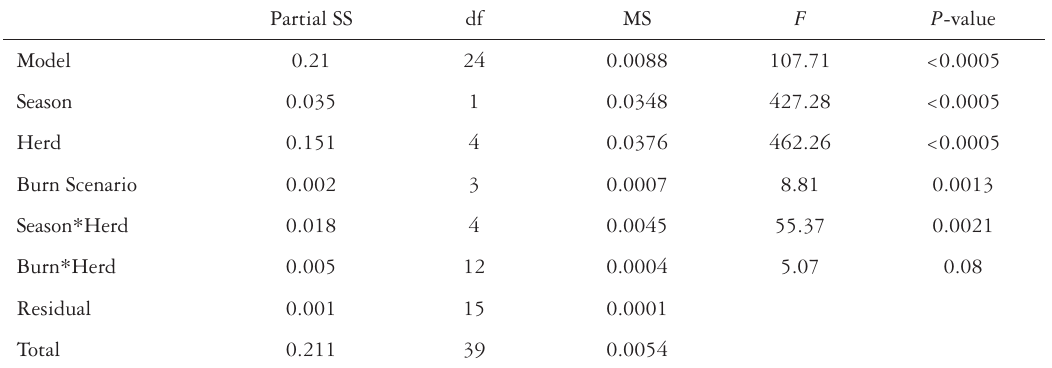
Table 4. ANOVA results for the effects of burn scenarios, season, and herd status on the percentage of caribou ranges occurring in safe zone habitat, measuring the indirect effects of fire on caribou mediated via increased wolf– caribou overlap. Seasons were winter, summer, and burn scenarios were prescribed burns, interior area, and buffer area burns. Both season*herd and burn*herd 2-way interaction were significant. Overall adjusted R 2 for the model was 0.985, n =40 landscape burn experiments.